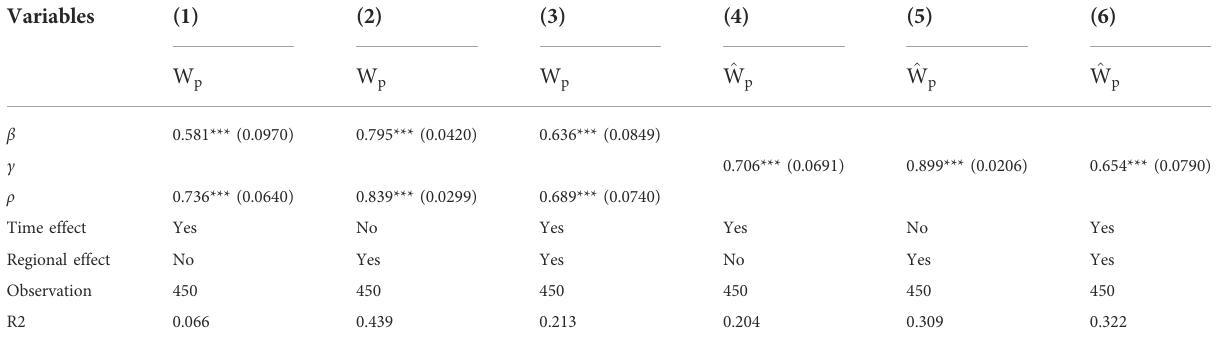
TABLE 5 Spatial measurement test of income disparities on atmospheric